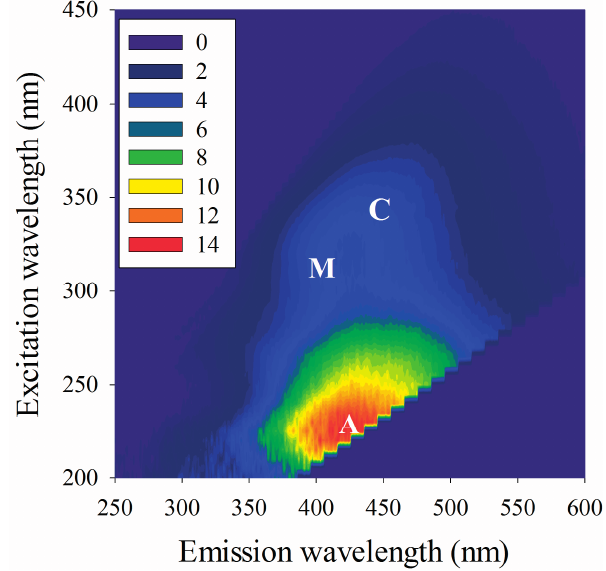
Figure 1. The fluorescence excitation-emission matrix (EEM) spectrum of a water extractable organic matter (WEOM) sample without metal